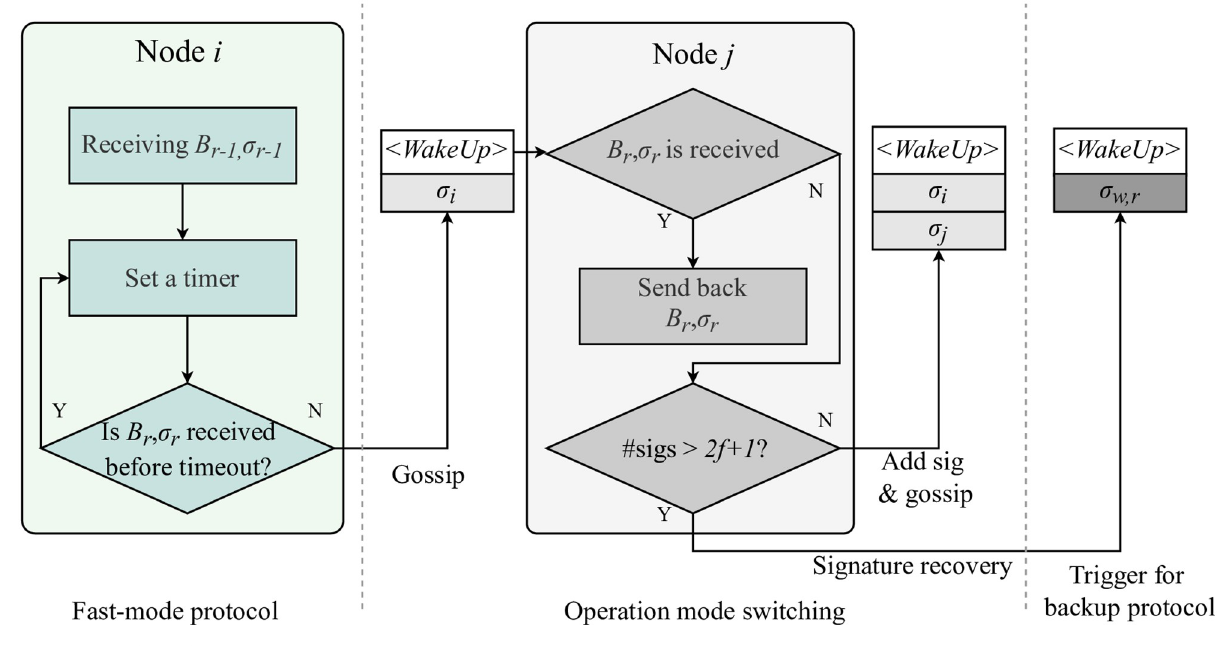
Fig 5. Protocol switching